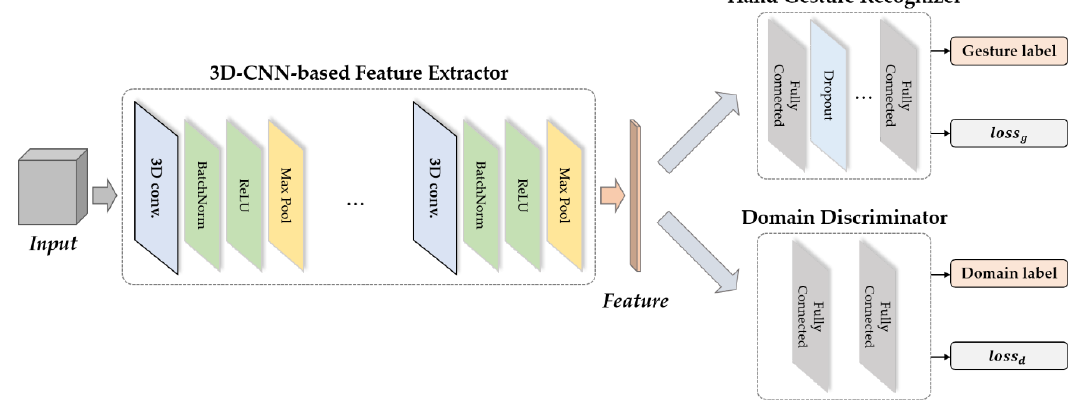
Figure 8. The overview of the proposed hand gesture recognition system.